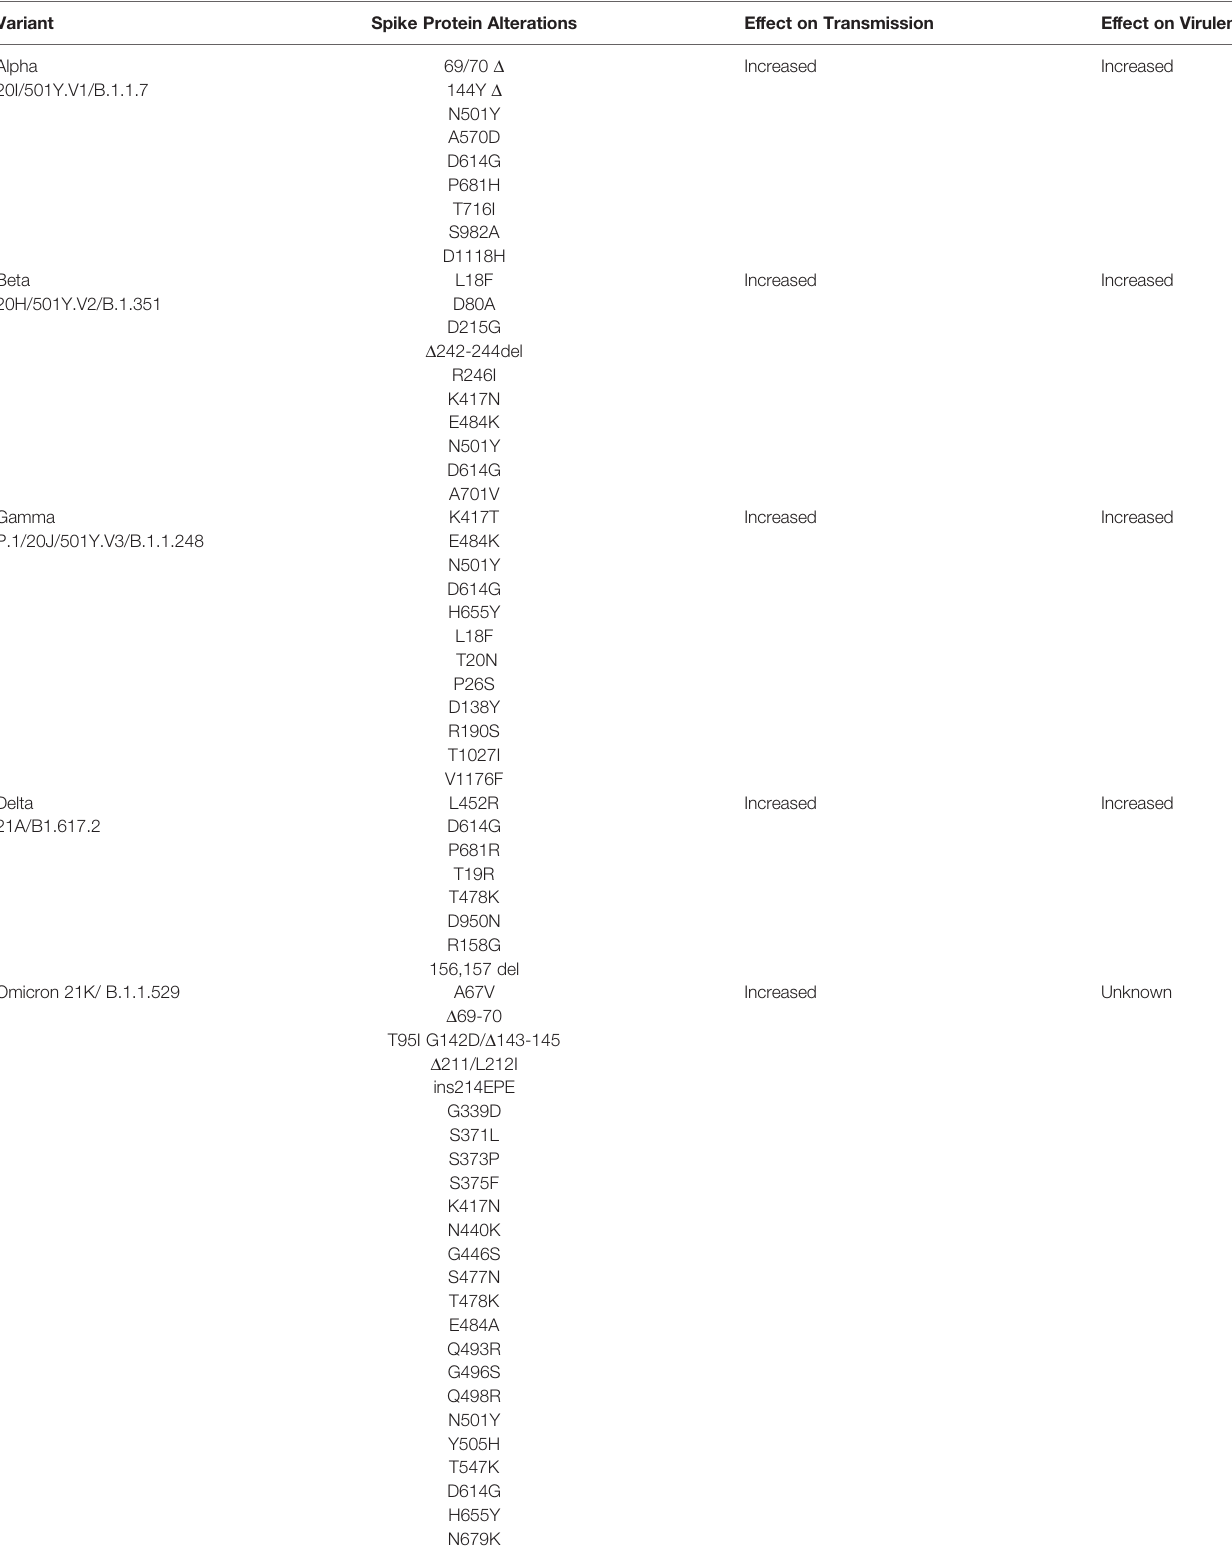
TABLE 1 | World Health Organization (WHO) SARS-CoV-2 variants of